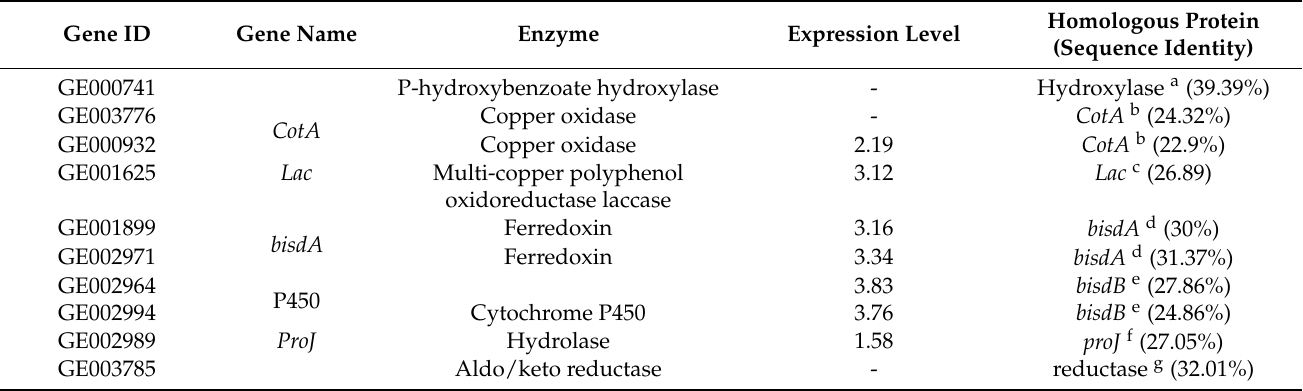
Table 2. Coding genes of key enzymes involved in Bisphenol A degradation in Pseudomonas sp.